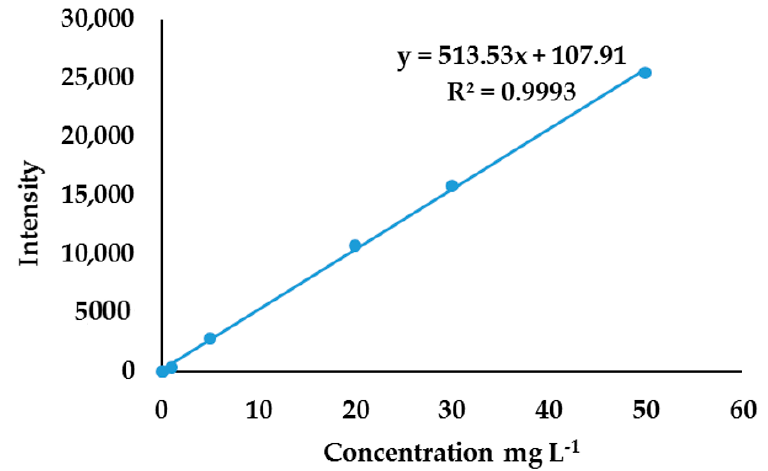
Figure 7. External calibration curve obtained by plotting intensity against the concentration of gold salt standard.